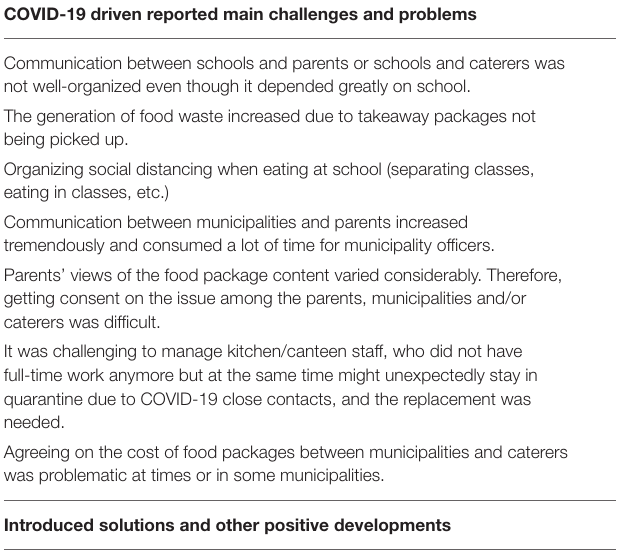
TABLE 3 | Challenges and positive developments during COVID-19 in Estonia. COVID-19 driven reported main challenges and